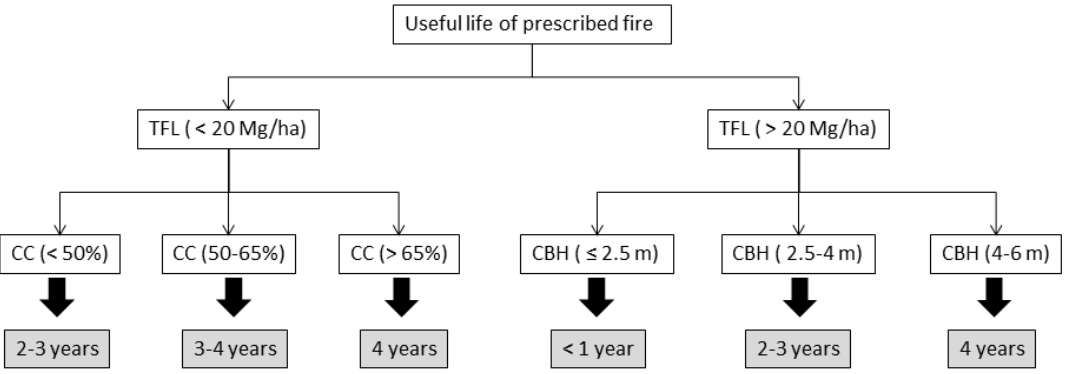
Figure 10. Decision tree for the estimation of the useful life of a prescribed fire. “TFL” is the total preburn fuel load (Mg/ha); “CC” is the canopy cover (%); “CBH” is the canopy base height (m).